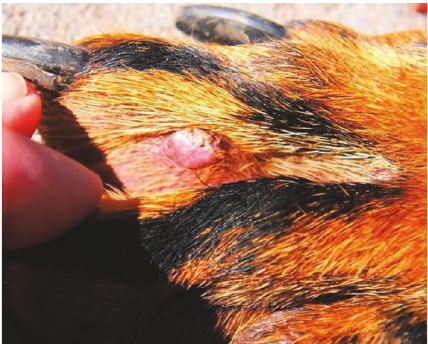
Figure 2: Interdigital inflammatory skin lesion closely resembling those observed in MKD patients. This patient had numerous such lesions on her extremities, trunk, and foot pads.